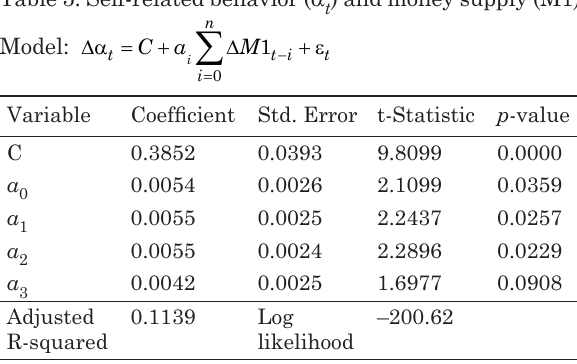
Table 5. Self-related behavior ( α